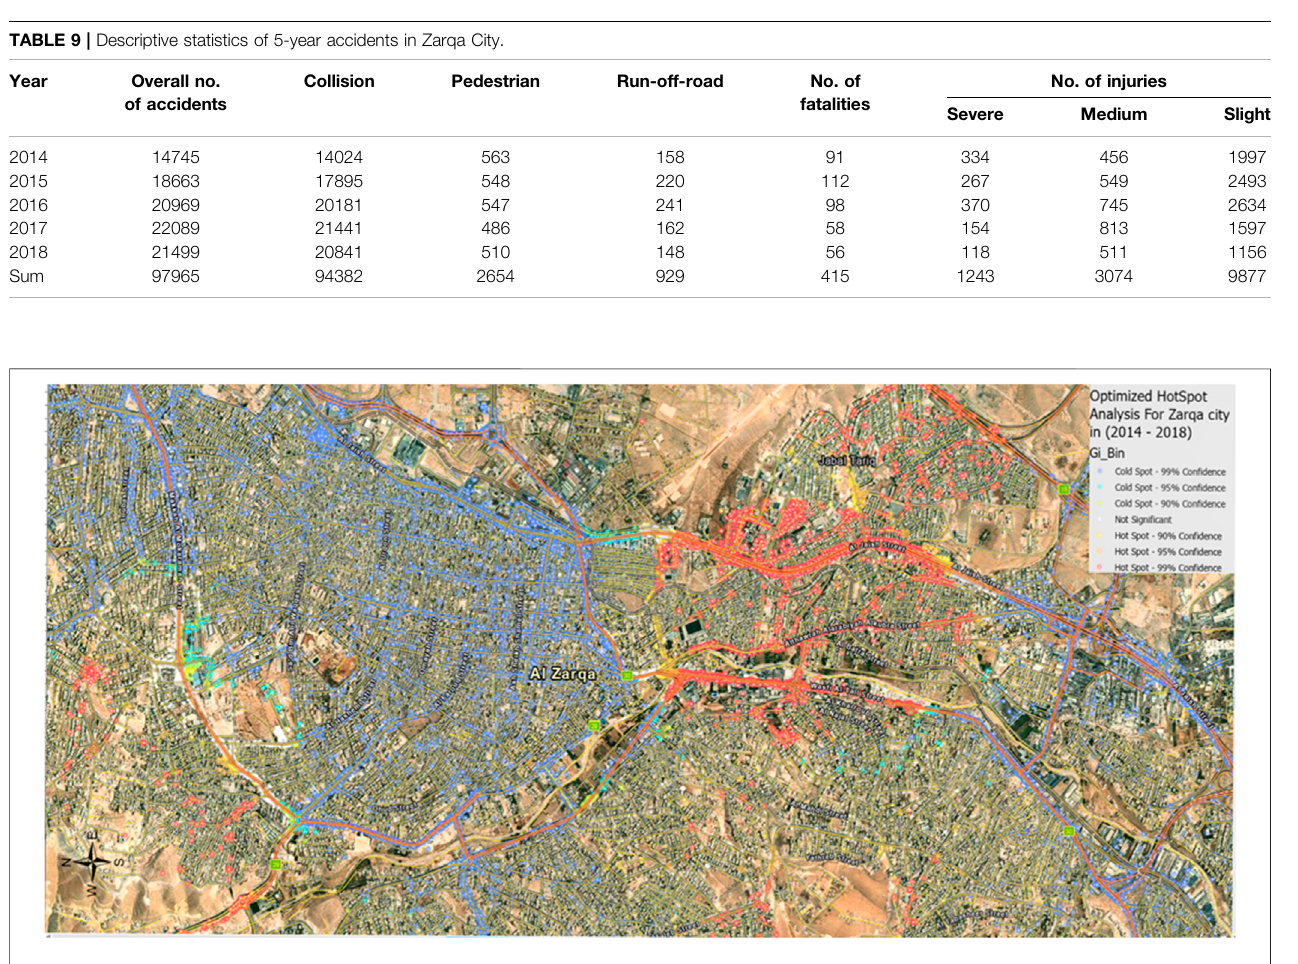
FIGURE 4 | Optimized hot spot analysis for Zarqa City in 2014 – 2018.